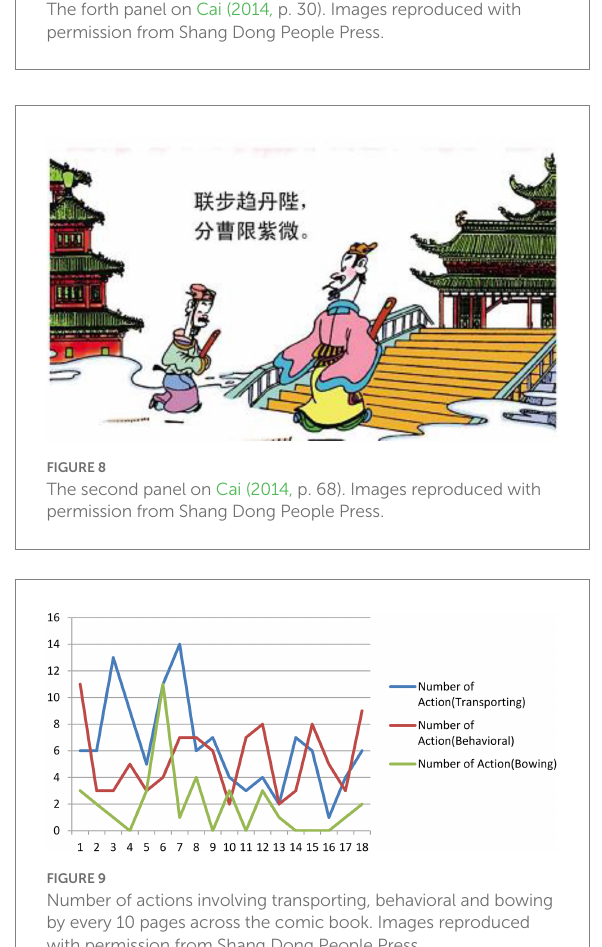
FIGURE 9 Number of actions involving transporting, behavioral and bowing by every 10 pages across the comic book. Images reproduced with permission from Shang Dong People Press.